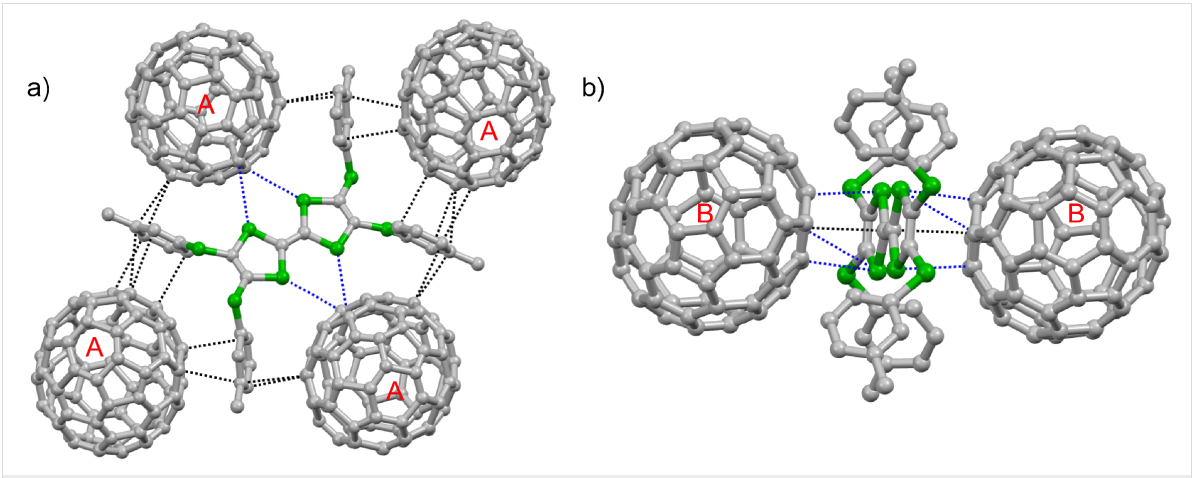
Figure 4: Crystal structure of 2 ·(C 70 ) 4 ·(PhCl) 2 . a) Interactions between C 70 molecule A and 2 ; b) Interactions between C 70 molecule B and 2 . The blue and black dashed lines indicated the intermolecular C–S and C–C contacts, respectively. The hydrogen atoms are omitted for clarity.